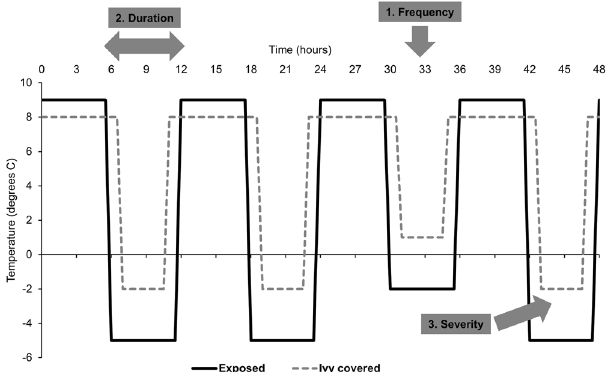
Figure 6. Experimental regimes used to simulate frost weathering in the laboratory. Two regimes were used representing ‘exposed’ and ‘ivy covered’ stone, accounting for ivy’s thermal blanketing as measured in the field. Adjustments were made for the frequency, duration and severity of freezing events, as indicated (also see Table